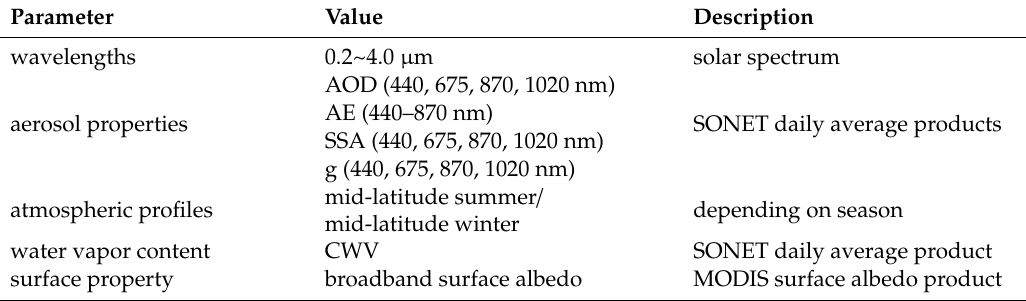
Table 2. Parameters adopted in the simulations of aerosol radiative forcing in this